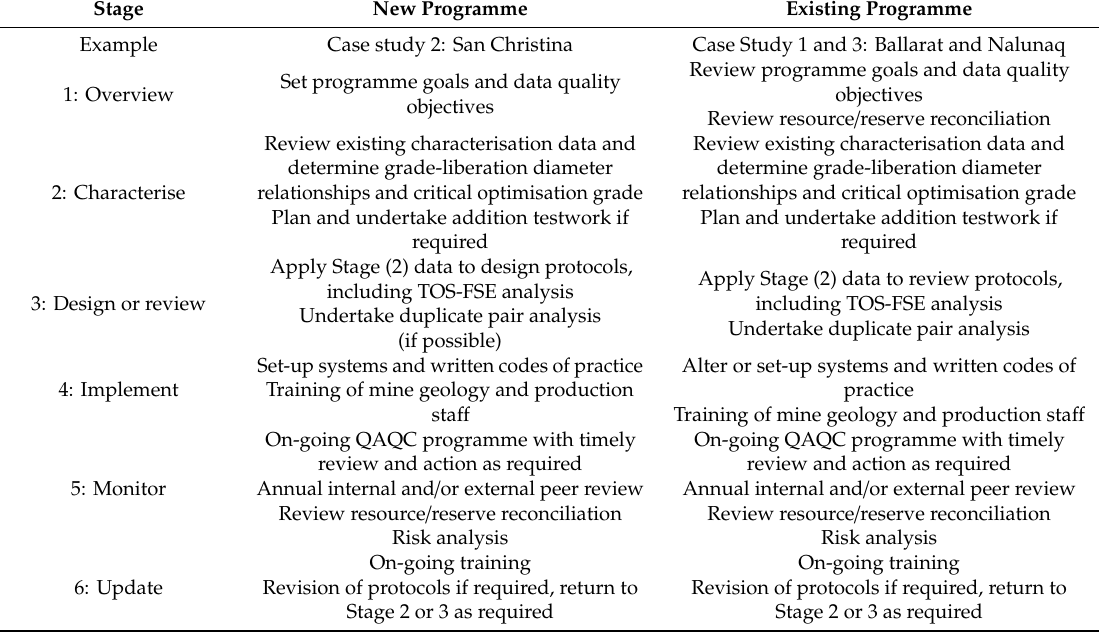
Table 35. Stages in the design of a new grade control programme and for the review of an existing programme. Detail may di ff er depending upon